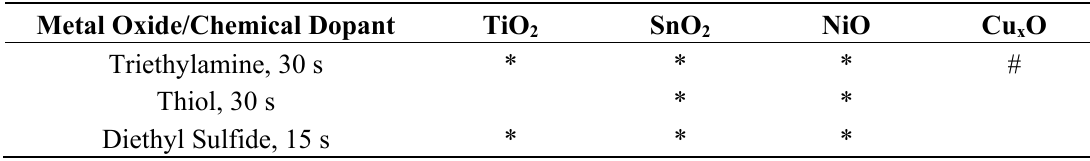
Table 1. Summary of metal oxide nanostructure deposits and chemical functionalization using nitrogen and sulfur compounds. The systems studied and in situ exposures are given in the table. * signifies the change in response to the analyte, NH paper. # signifies the change in response with the analytes, NH the